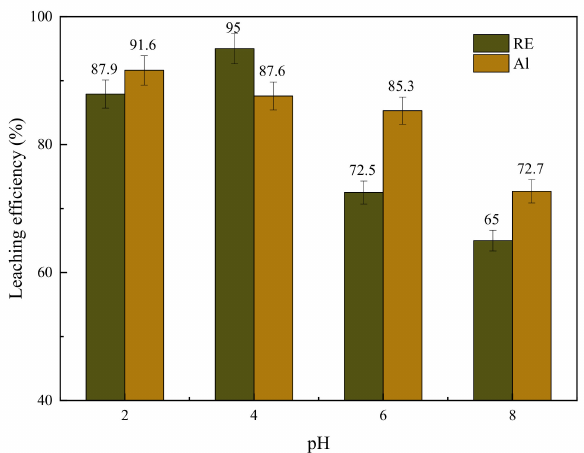
Figure 15. The leaching e ffi ciencies of RE and Al under di ff erent pH